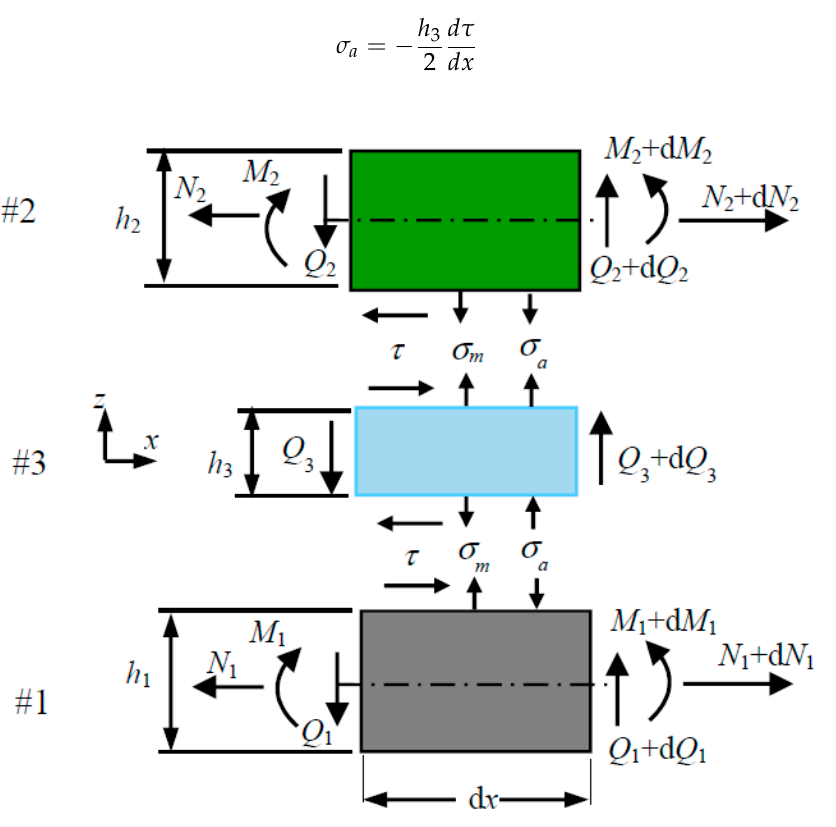
Figure 2. Elemental representation of a bonded structure.